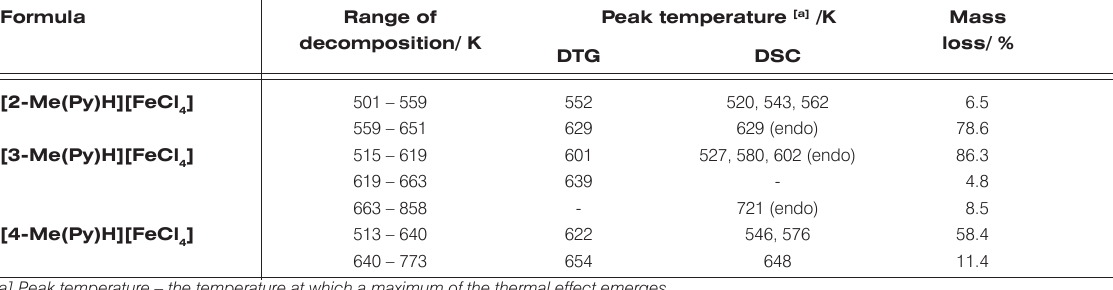
Figure 3. TG and DSC curves of the thermal decomposition of [2-Me(Py)H][FeCl (3) in argon. Table 3. Thermal characteristics of [2-Me(Py)H][FeCl Formula Range of